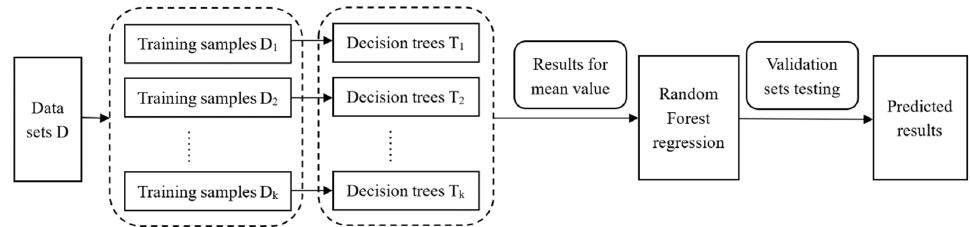
Figure 2. Steps of the random forest regression model.